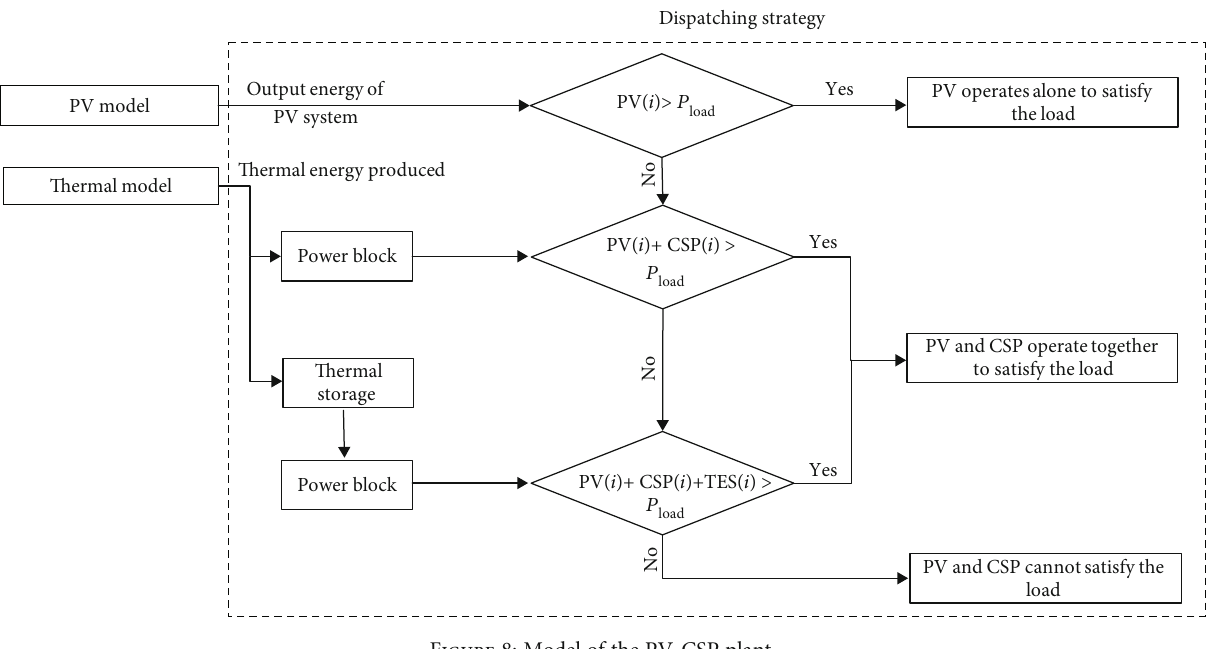
Figure 8: Model of the PV-CSP plant. Table 5: Simulated plant con fi gurations.